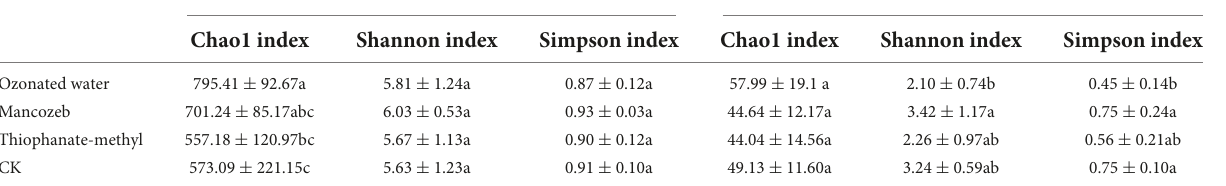
TABLE 1 Bacterial and fungal alpha diversity